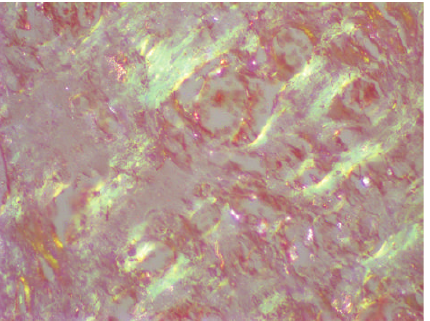
Figure 5: Material was confirmed apple green under polarized